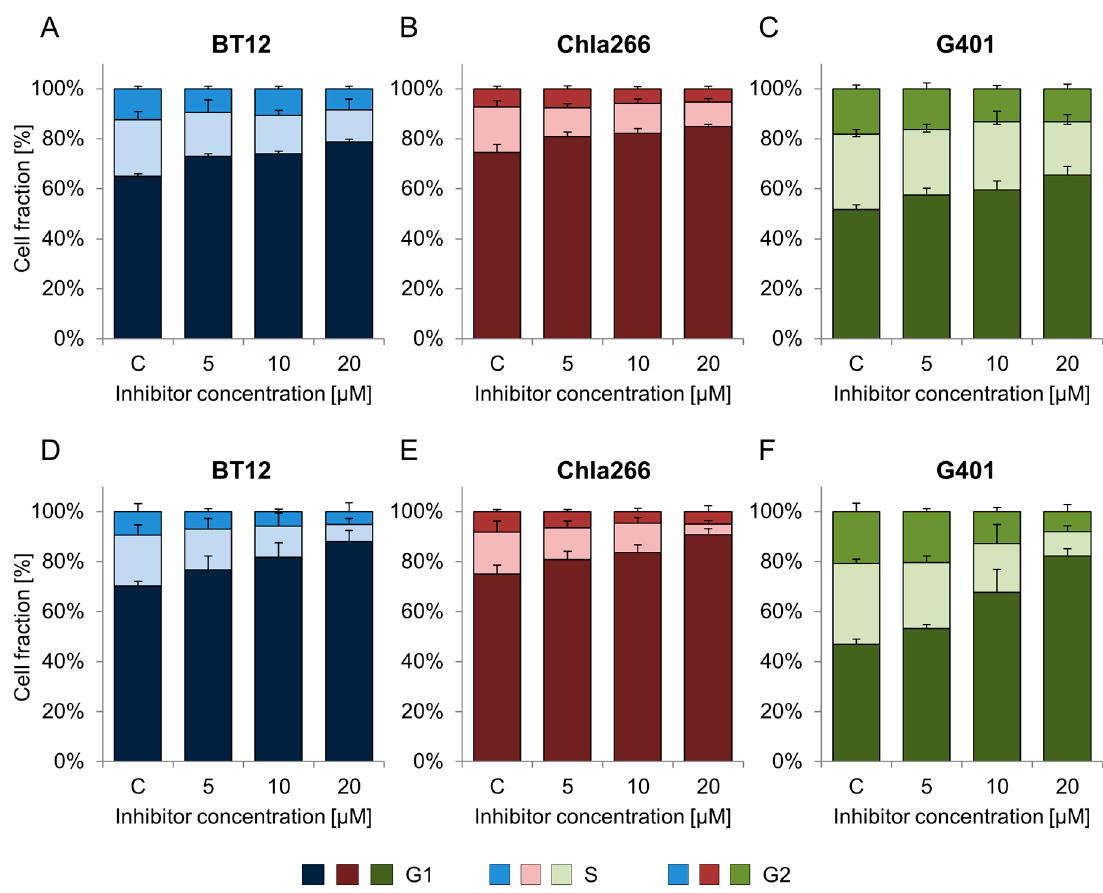
Figure 2. Impact of BRD9 inhibitors on cell cycle in RT. Different RT cell lines were treated with BI-9564 ( A – C ) or I-BRD9 ( D – F ) inhibitors in a range of 5 to 20 µM and incubated for 72 h. Cell cycle profiles, defined by G1, S and G2 phases, of BT12 ( A , D ), Chla266 ( B , E ) and G401 ( C , F ) cell lines are shown. (c = control; n ≥ 3; error bars indicate SD).